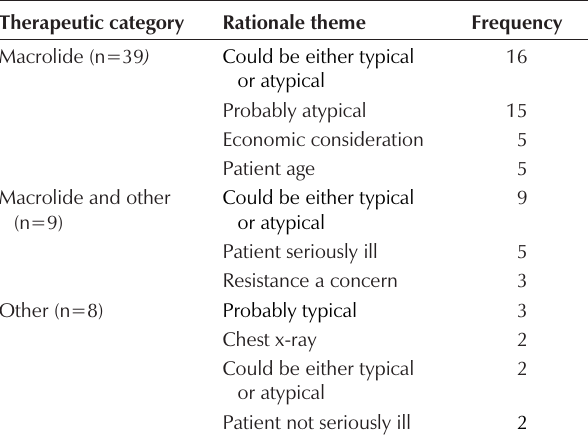
Three most commonly occurring rationale themes in case 1 (open-ended questionnaires), by therapeutic category